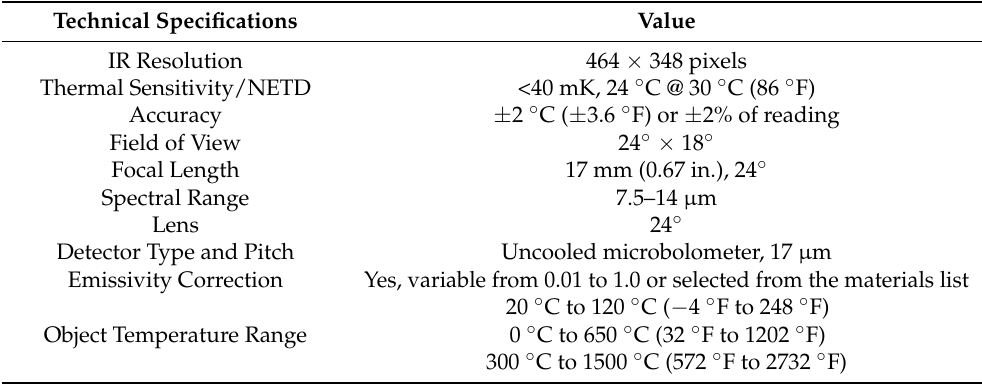
Table A1. FLIR ® T540 Thermal Camera: Technical Specifications.